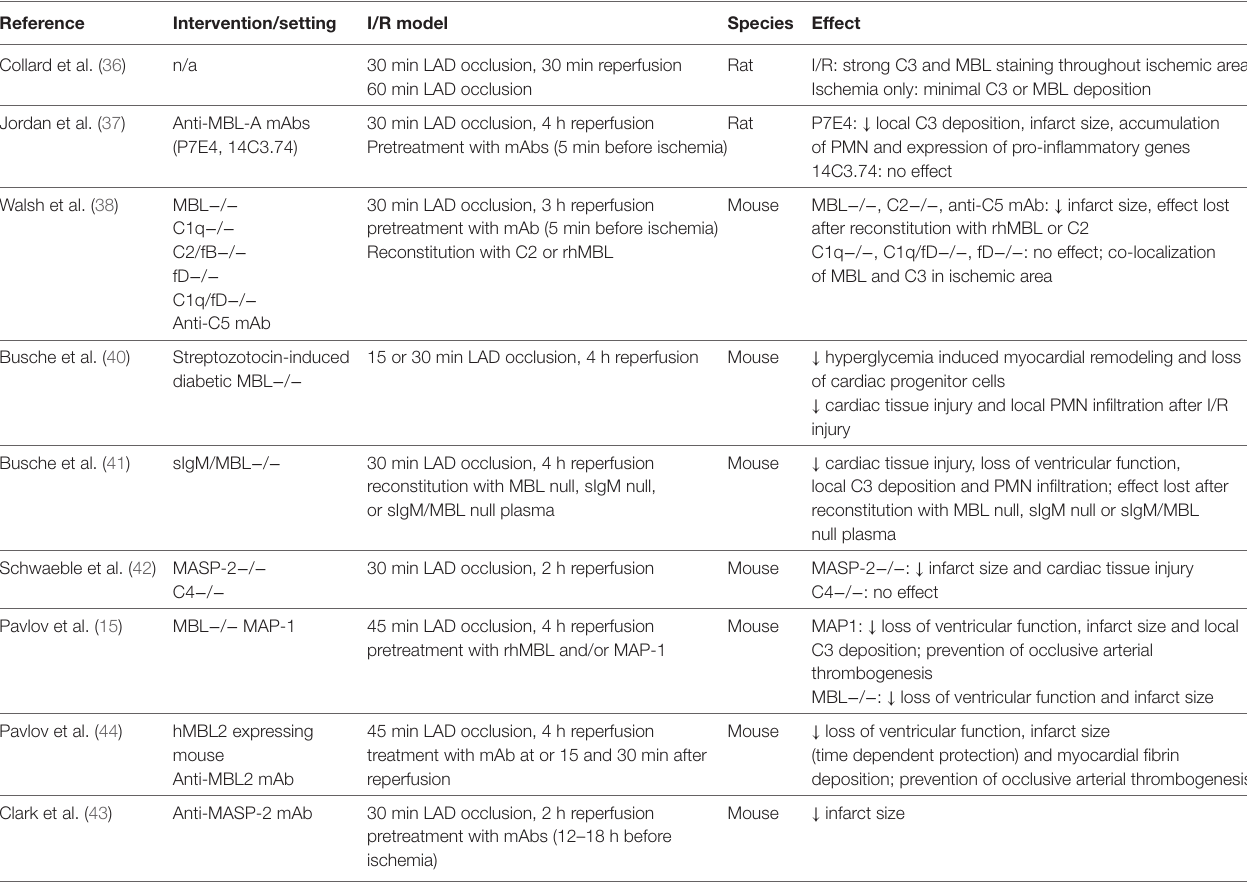
TABLe 1 | Experimental studies investigating the role of the lectin pathway in murine myocardial I/R. Reference